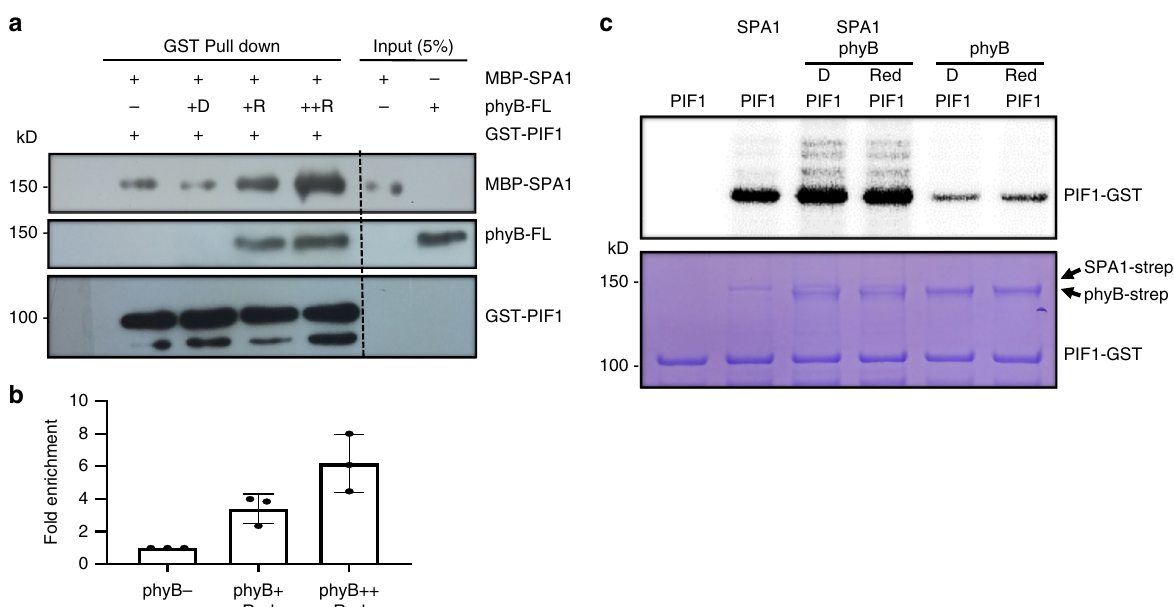
Fig. 5 PhyB interaction with SPA1 promotes phyB-SPA1-PIF1 trimolecular complex formation and enhanced phosphorylation of PIF1 in vitro. a In vitro pull- down assay shows that phyB enhances PIF1-SPA1 interaction in a light- and concentration-dependent manner. b Bar graph shows the enhanced interaction between SPA1 and PIF1 in the presence of phyB. Error bar = SD, ( n = 3). c (top panel) Autoradiogram shows that phyB enhances SPA1-mediated phosphorylation of PIF1 in vitro. (Bottom panel) Coomassie-stained gel shows the amount of various proteins used in the